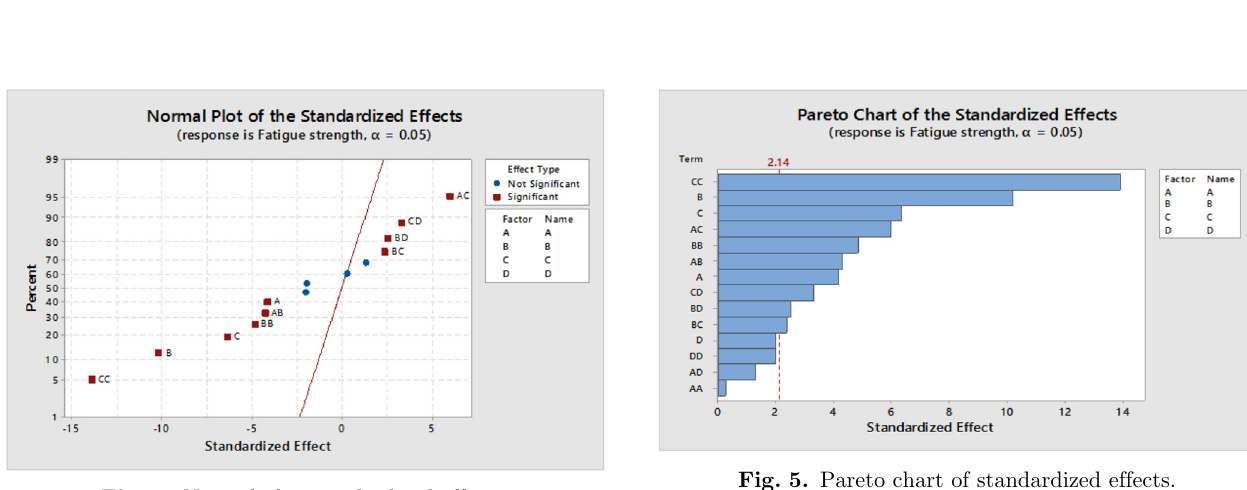
Fig. 4. Normal plot standardized effects.